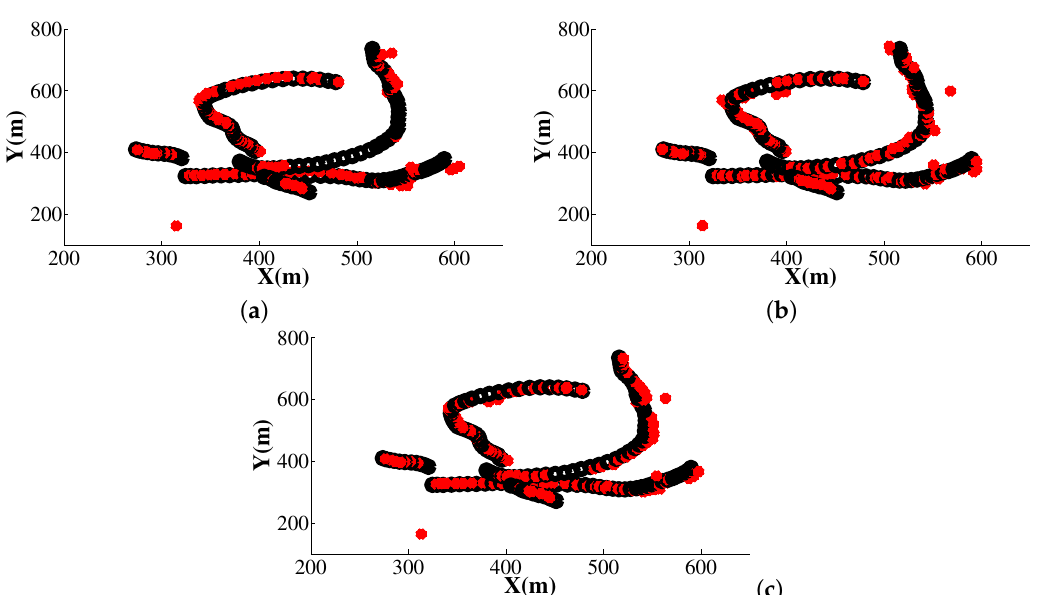
Figure 3. Estimated trajectories of three approaches with clutter number being 10. The estimated trajectories are represented with the red (light) points, while the true trajectories are with the black (dark) solid line. ( a ) Trajectories of IBSMC-PHD; ( b ) Trajectories of CISMC-PHD; ( c ) Trajectories of F-CISMC-PHD.